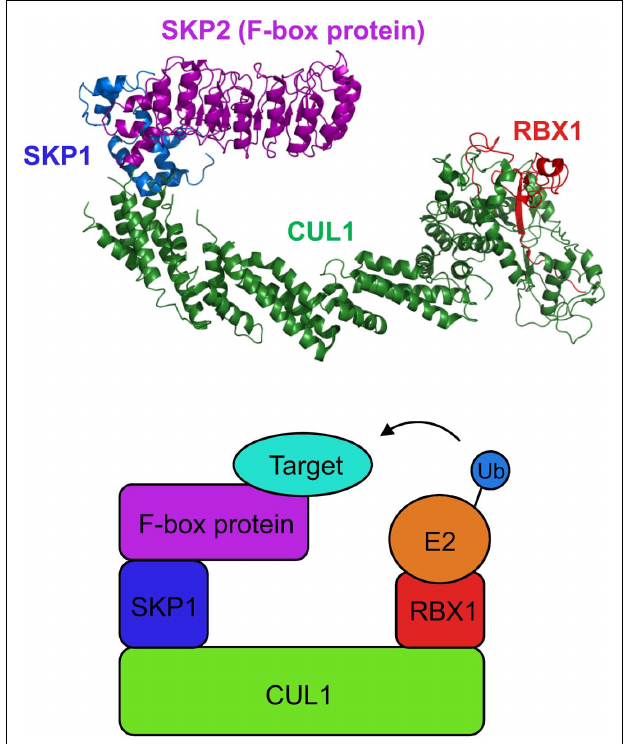
FIGURE 2 | Structure of the SCF complex. The crystal structure of the yeast SCF SKP2 complex (top; Zheng et al., 2002; Hao et al., 2005; assembled from Protein Data Bank files 1LDK and 2ASS) and a simplified cartoon of the SCF complex (bottom).The N-terminal half and the C-terminal half of CUL1 interact with SKP1 and RBX1, respectively. RBX1 serves as a docking site for an E2 enzyme. An F-box protein interacts with SKP1 via its F-box domain and recruits the target protein to the ubiquitin ligase